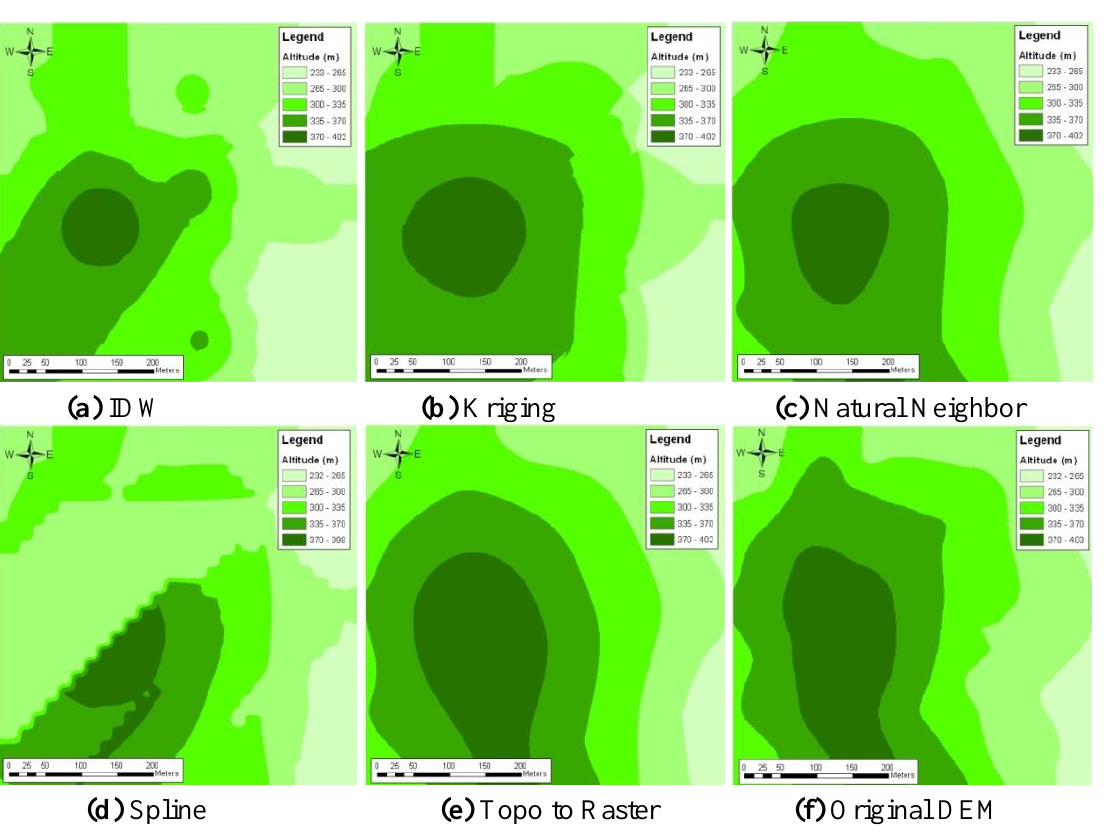
Figure 5. Interpolated DEM with only perimeter and nine sample points of T1 test